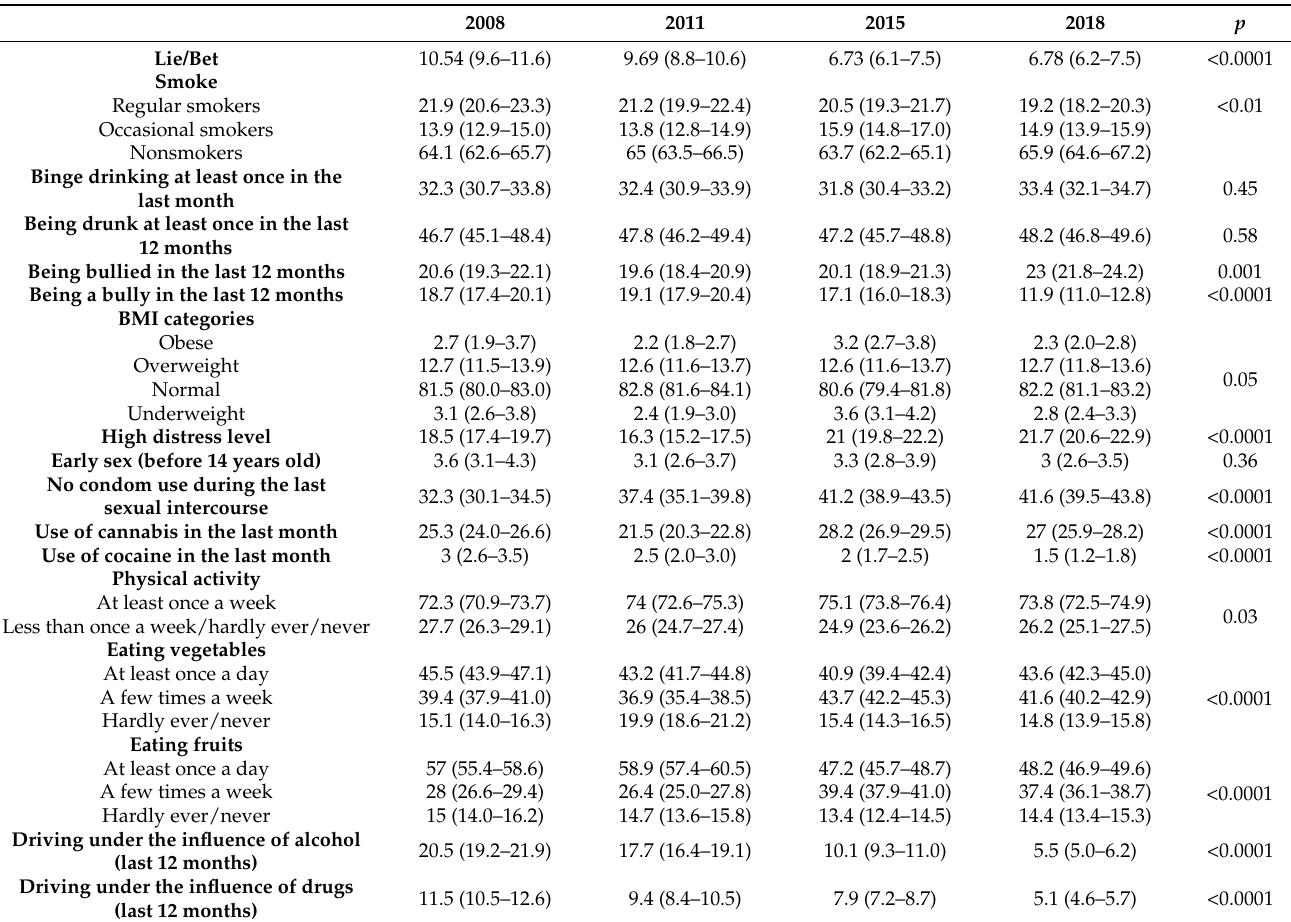
Table 2. Overall trends of the prevalence of health risk behaviors and health conditions (survey waves 2008, 2011, 2015, and